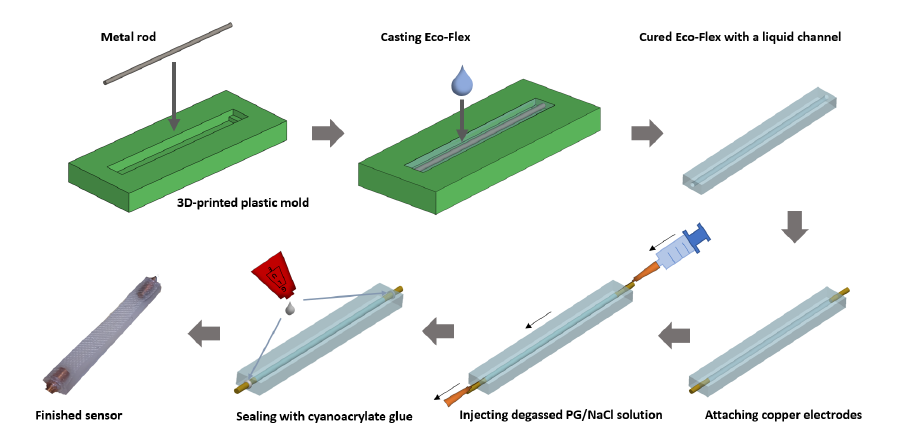
Figure 2. The fabrication procedure of the flexible strain